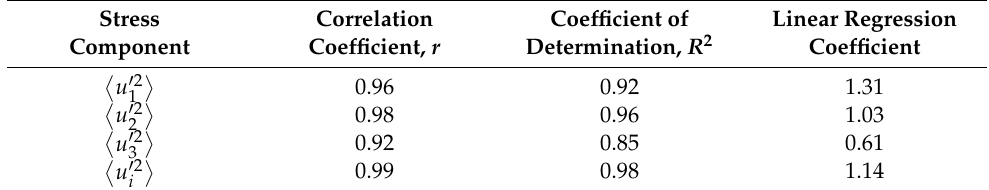
Table 1. Comparison of stress computations by two independent